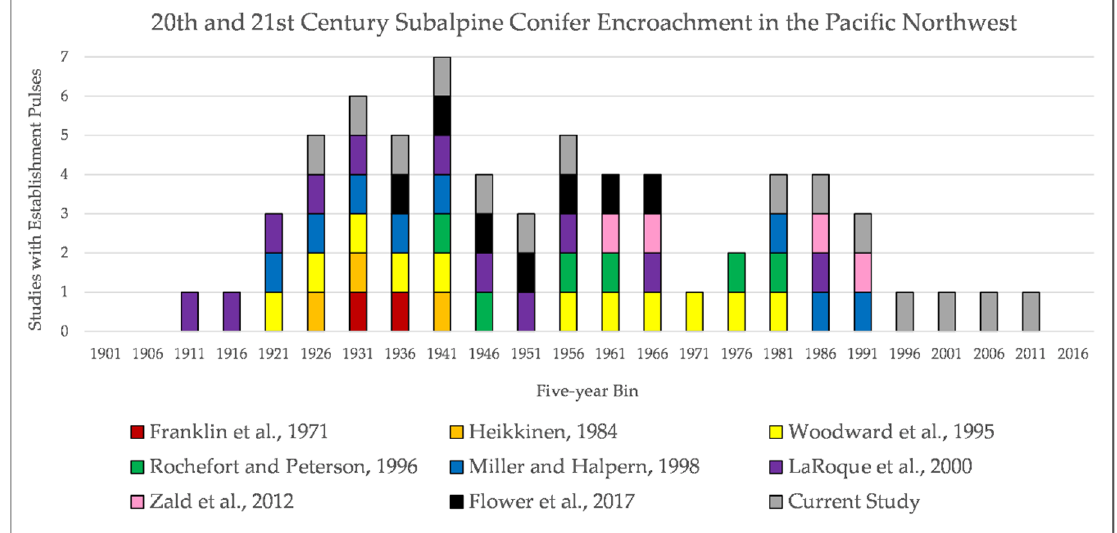
Figure 14. Pulses of conifer establishment using nine different studies in the Pacific Northwest.